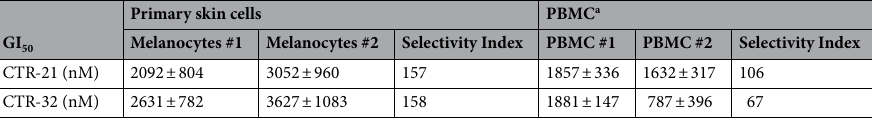
Table 2. GI 50 values of quinolone chalcone analogs on primary skin and blood cells. GI 50 values were derived from a non-linear sigmoidal dose–response (variable slope) curve fitted by GraphPad Prism v.4.03 software. a PBMC denotes peripheral blood mononuclear